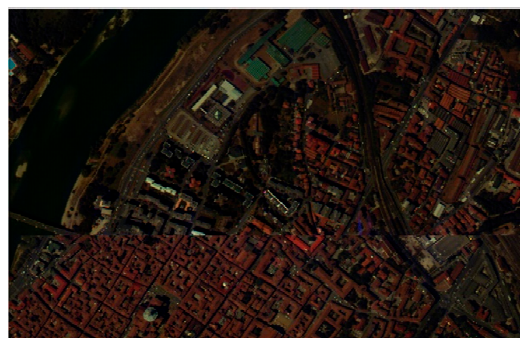
Figure 6. Pavia center hyperspectral image scene.